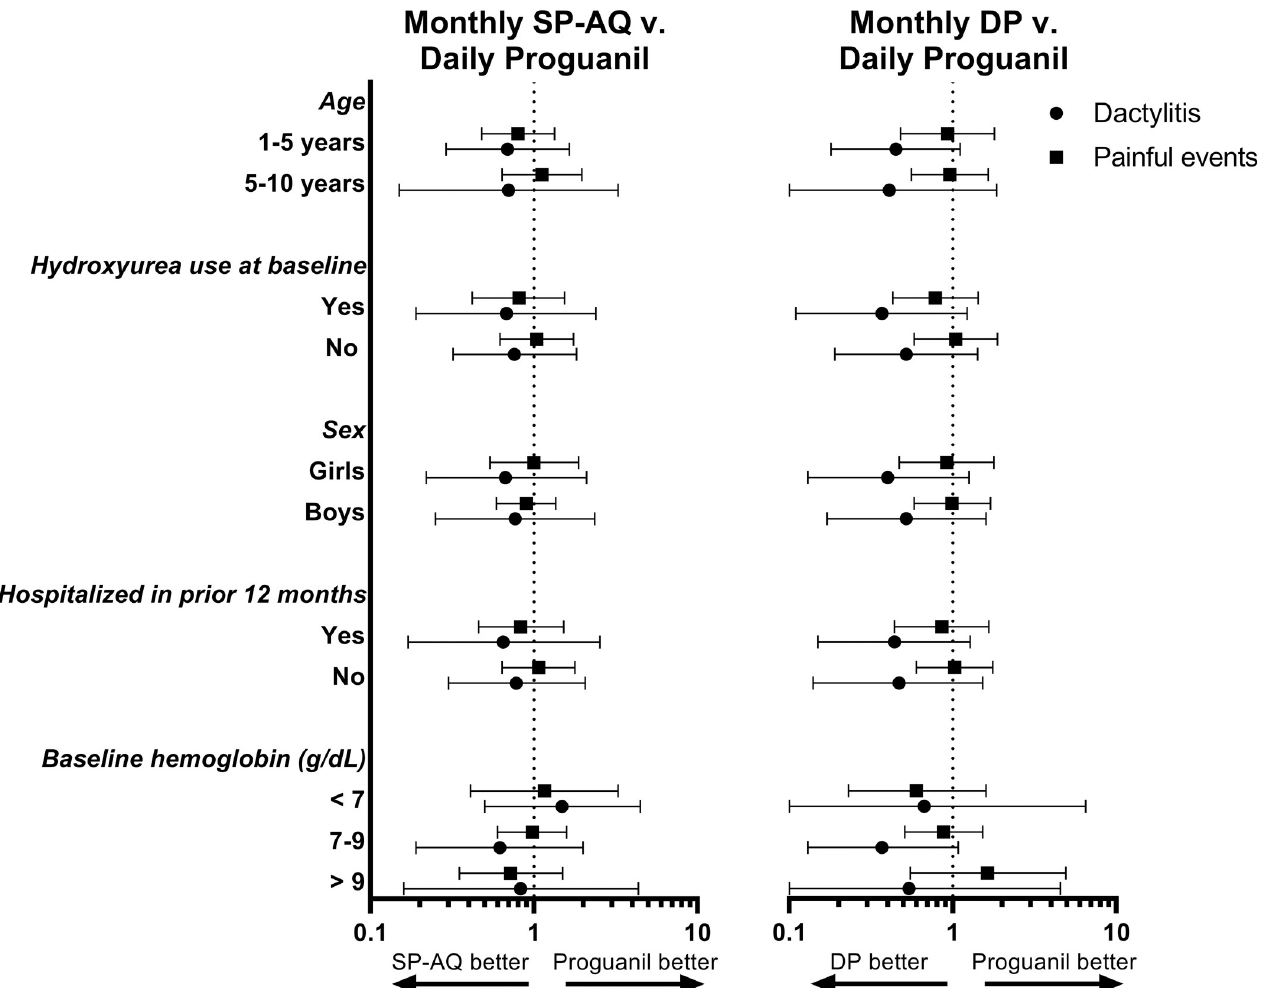
Fig 2. Main hematologic outcomes in the AT population according to subgroup. Points are estimates of the IRR relative to daily Proguanil. Bars are 95% CI. AT, As-Treated; CI, confidence interval; DP, dihydroartemisinin-piperaquine; g/dL, grams per deciliter; IRR, incidence rate ratio; SP-AQ, sulfadoxine/